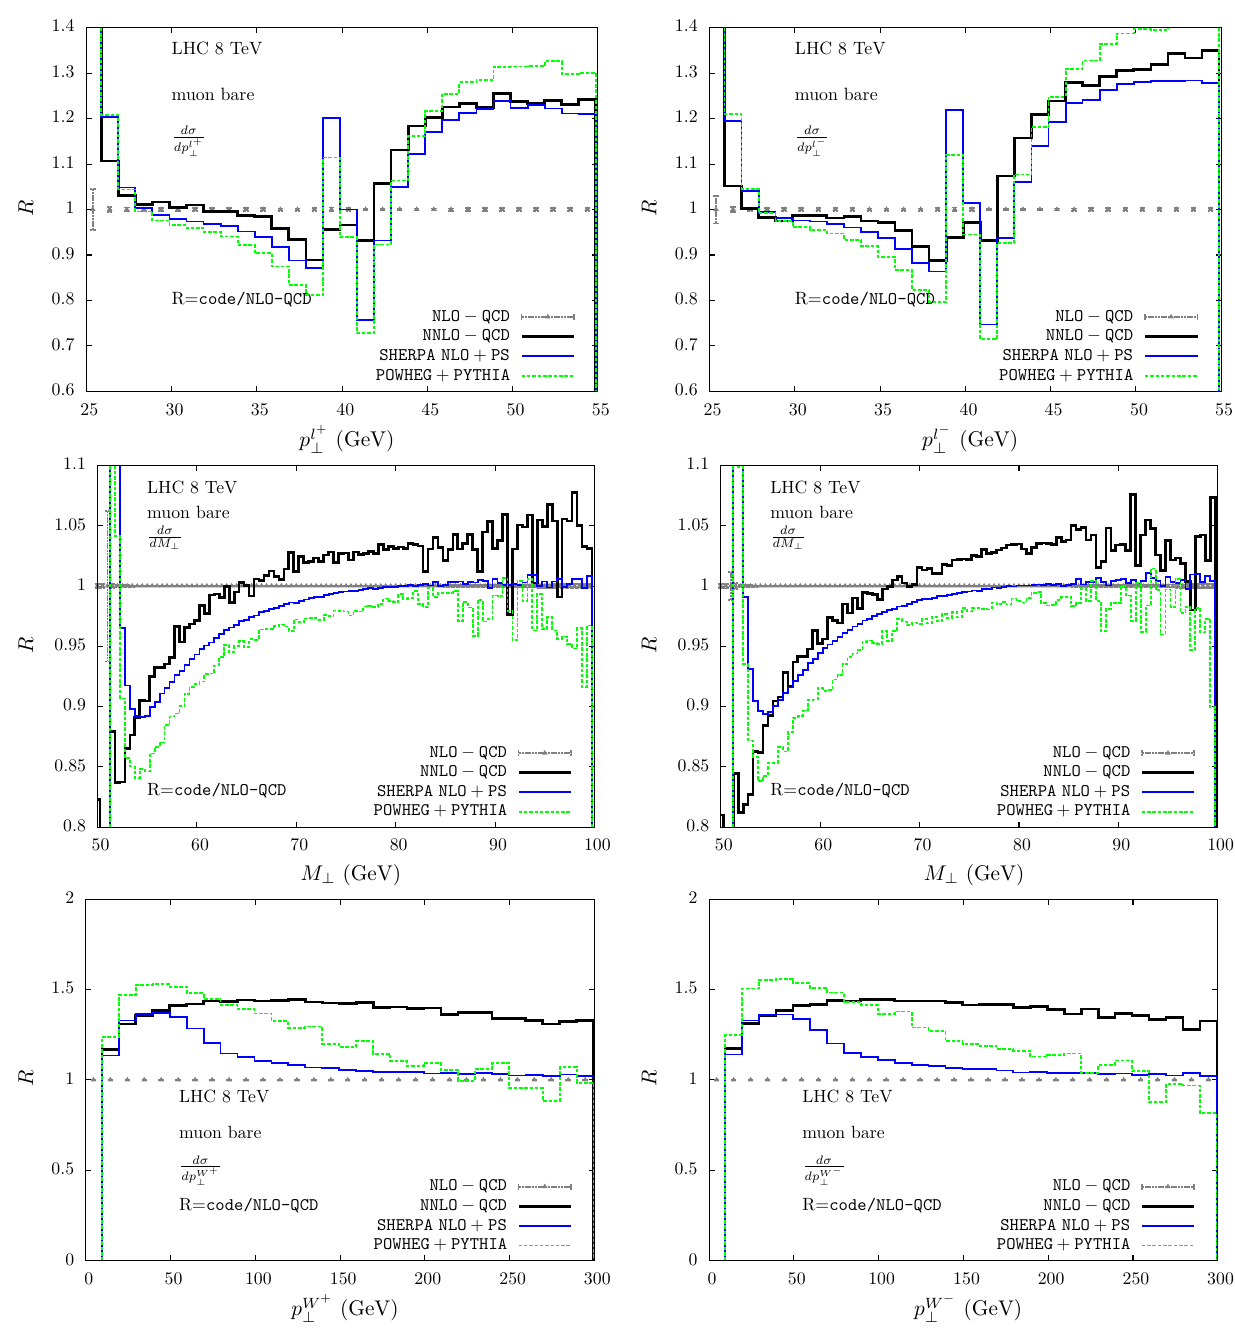
Fig. 20 Higher-order QCD effects, expressed in units of NLO QCD, in pp → μ ± ν μ + X , due to the matching of resummed and fixed order results, in codes with NLO accuracy: POWHEG + PYTHIA ( green ) and SHERPA NLO+PS ( blue ). The fixed-order NNLO QCD results are showninblack.Comparisonofresultsfortheleptontransversemomen-